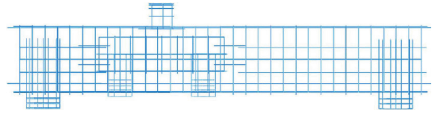
Figure 20: Steel bar diagram of MT-1.